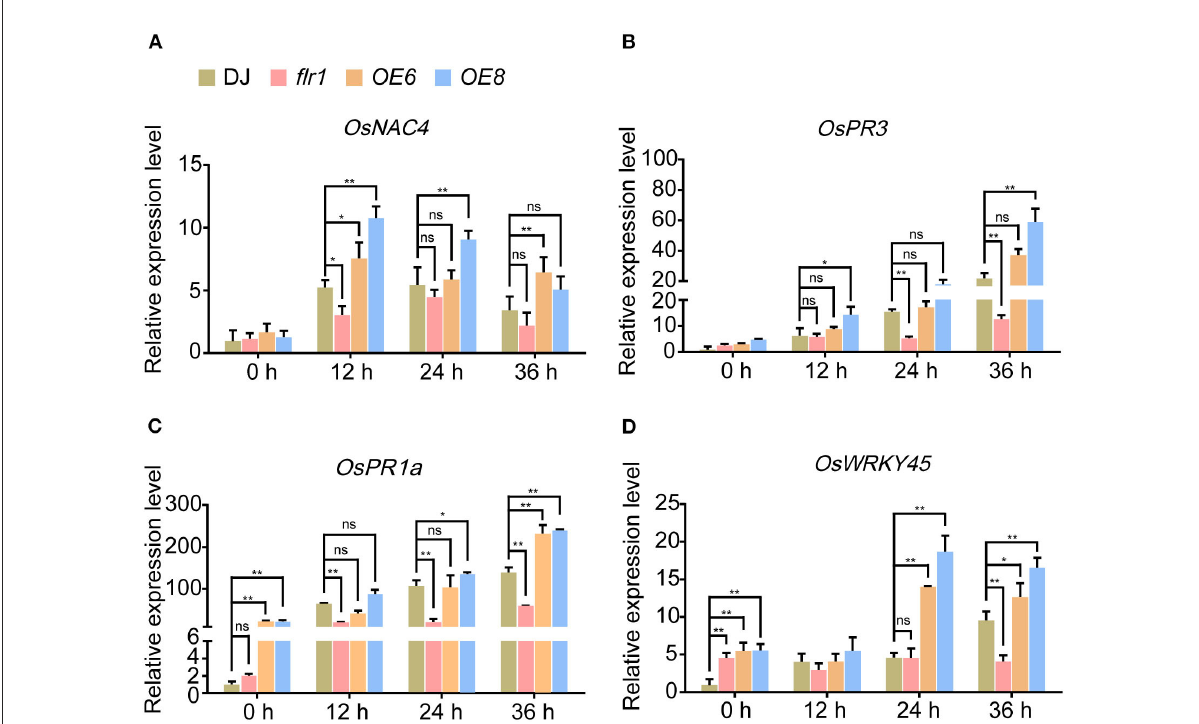
FIGURE2 Expression of defense-related genes in flr1 mutant and OE plants after infection with M. oryzae . (A–D) The experiment included three biological replicates, each with three technical replicates. Values represent means ± SDs ( n = 6), and asterisks above bars indicate significant differences from the control, as determined by a one-way ANOVA followed by Tukey’s test (* P < 0.05; ** P <